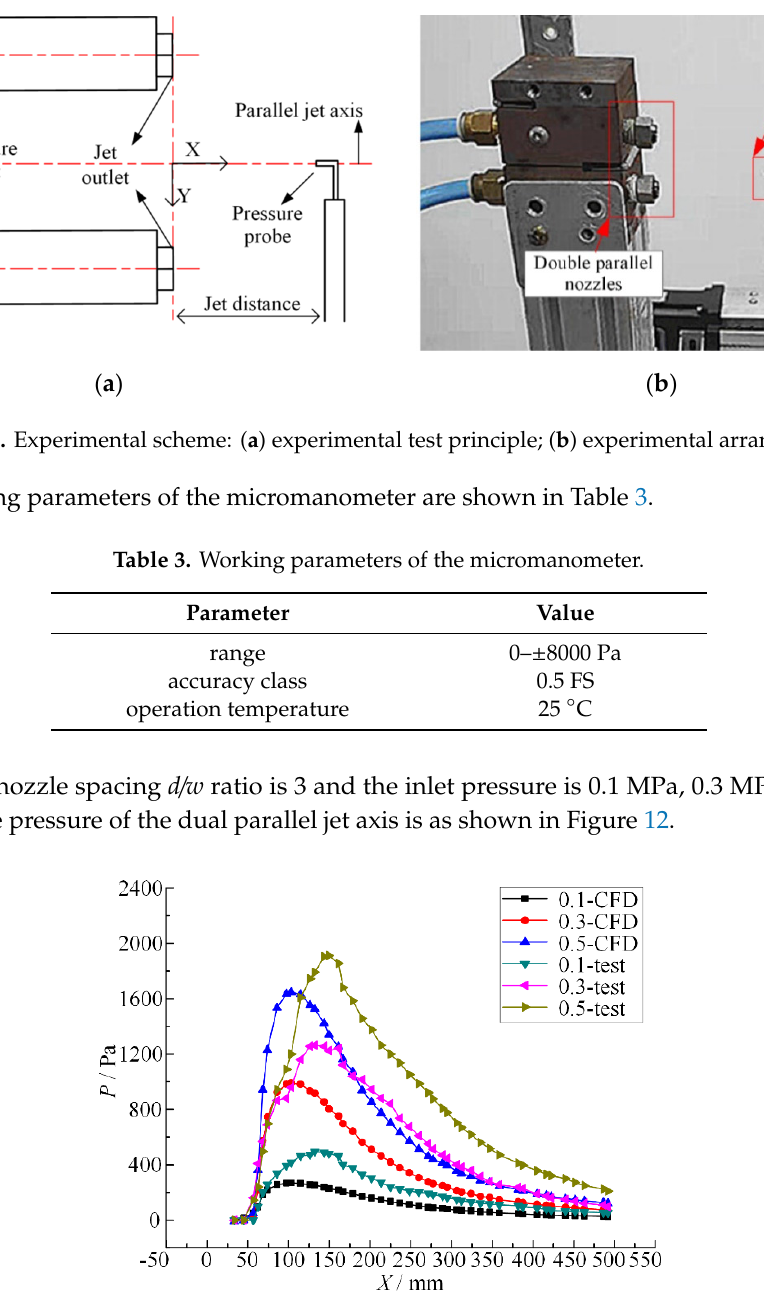
Figure 12. Pressure curves of the dual parallel jet axis with different inlet pressures.